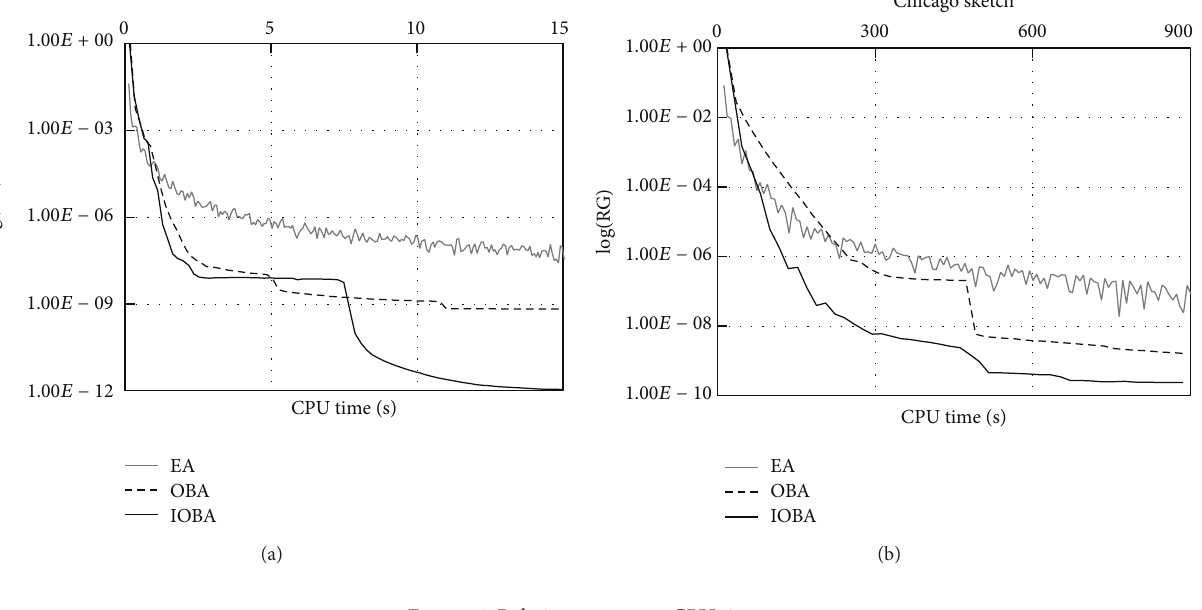
Figure 1: Relative gap versus CPU